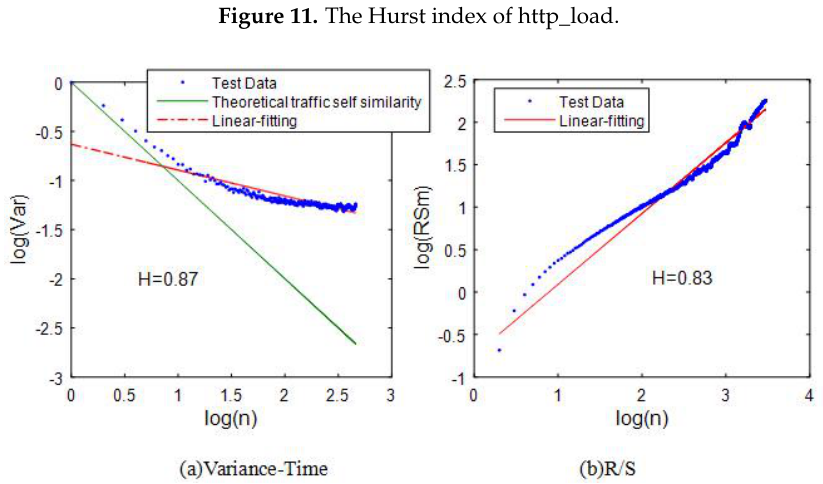
Figure 12. The Hurst index of